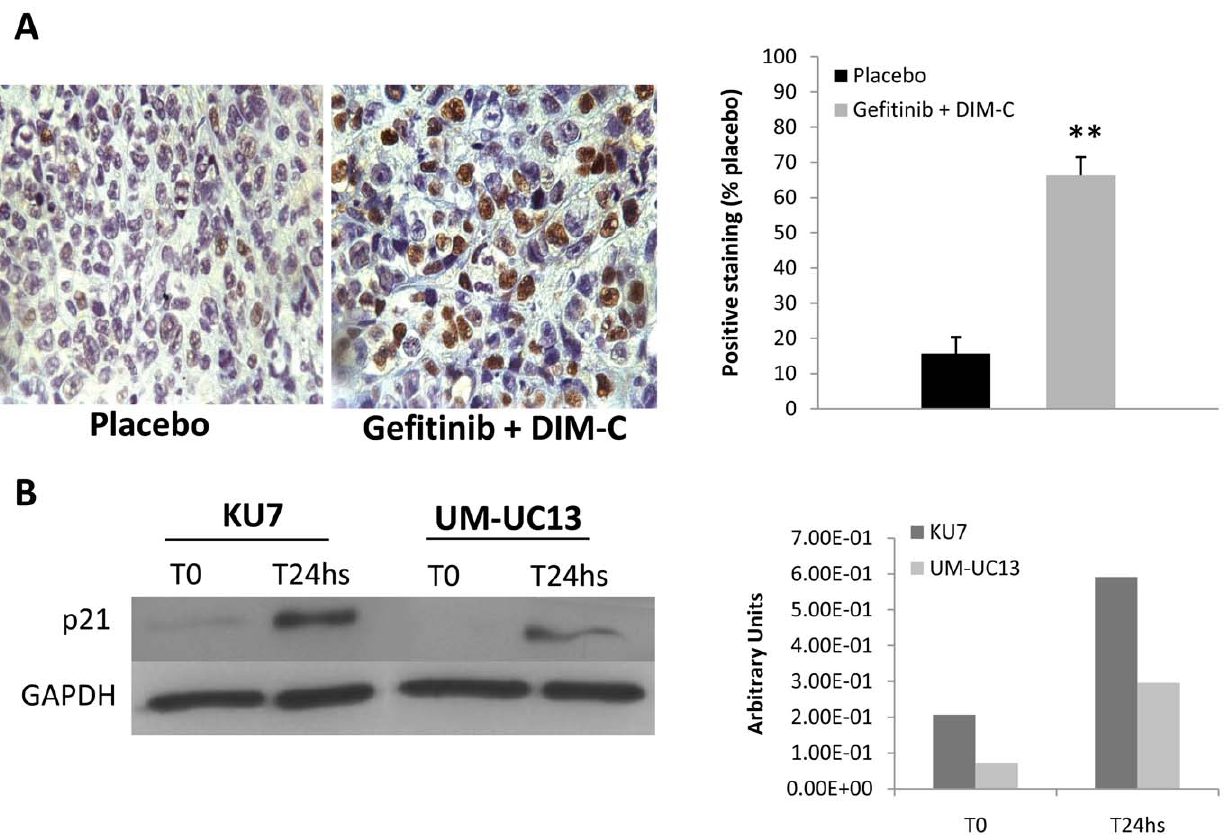
Figure 5. Effects of combination therapy on p21 expression invivo and invitro . (A) Immunohistochemistry (IHC) staining for p21 in tumor xenograft tissues. Mice were treated with placebo or combination therapy (Gefitinib 2 mg/day, 5 times per week and DIM-C 60 mg/Kg, 3 times per week). Graphic on the right side represents quantification of positive staining cells. (B) In vitro expression of p21 in Western blot of lysate cells treated with gefitinib 5 m M and DIM-C 3 m M for 24 hs. Graphic on the right side, represents quantification of p21 expression related to GAPDH.